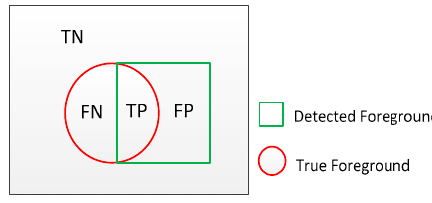
Figure 8. True and detected foreground in background subtraction.